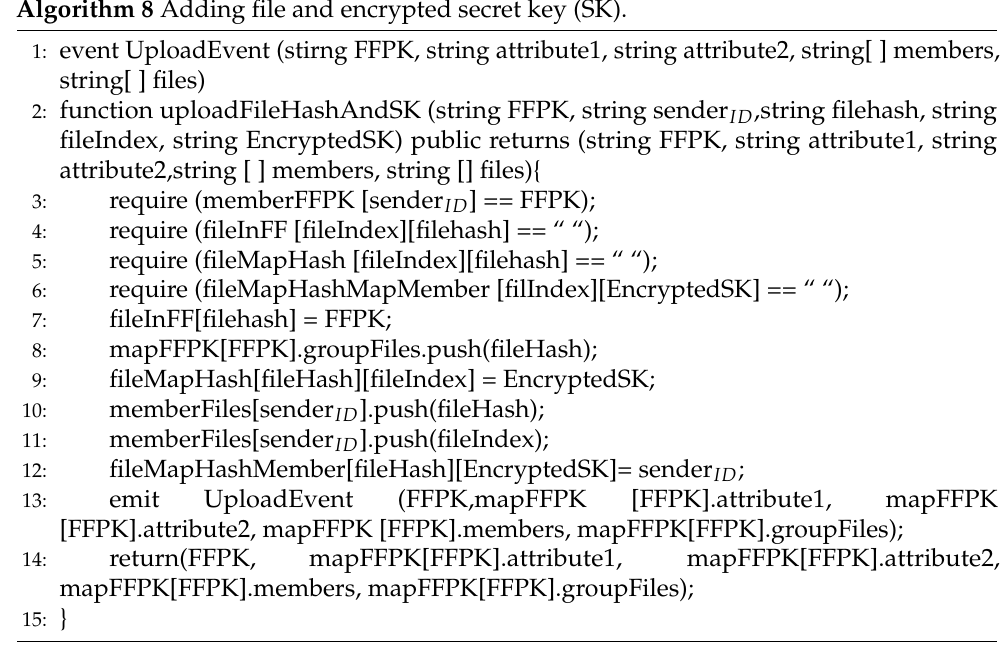
Algorithm 8 Adding file and encrypted secret key